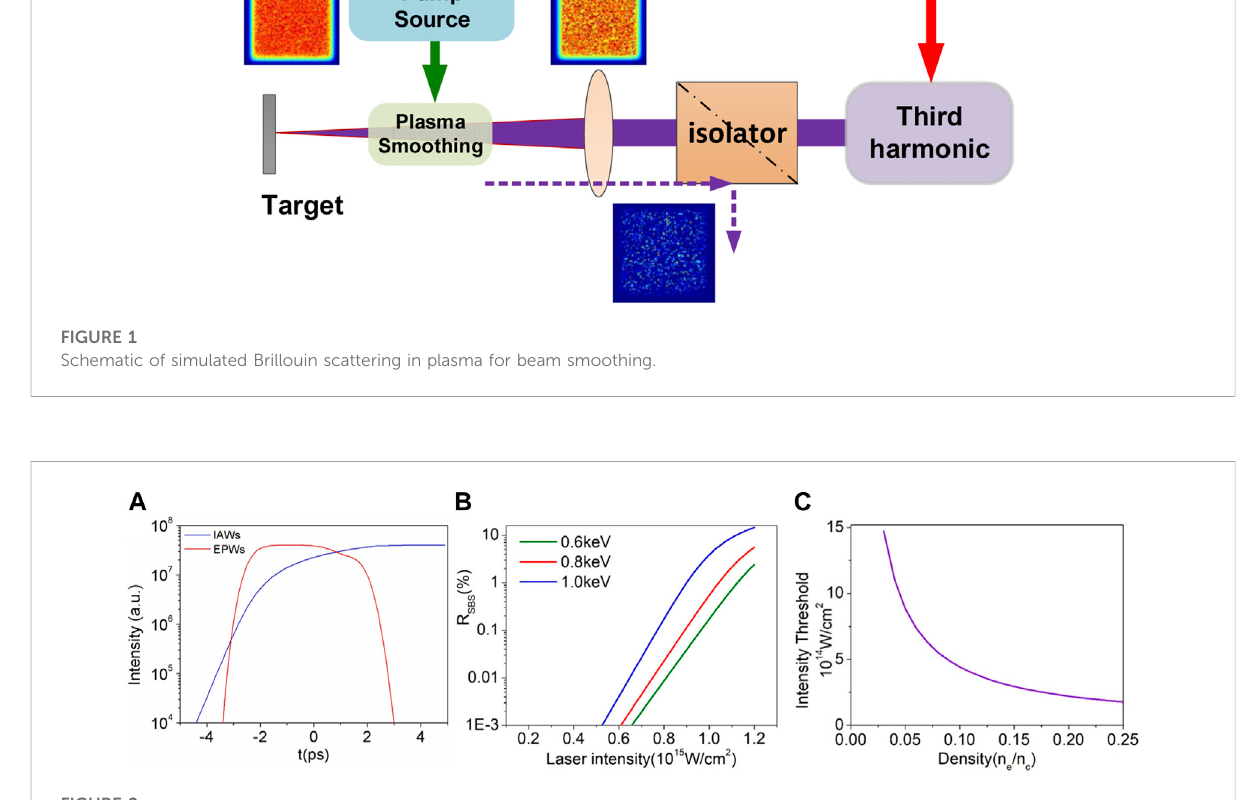
FIGURE 2 Theoretical simulation results of SBS proprieties in plasma. (A) Temporal evolution of scattered intensities of ion acoustic waves (IAWs) and electron plasma wave (EPW) driven by the 2-ps laser pulse. (B) Re fl ectivity results as a function of laser intensity for T e of 0.6, 0.8, and 1.0 keV. (C) Intensity at which SBS reaches 1% (intensity threshold) as a function of plasma